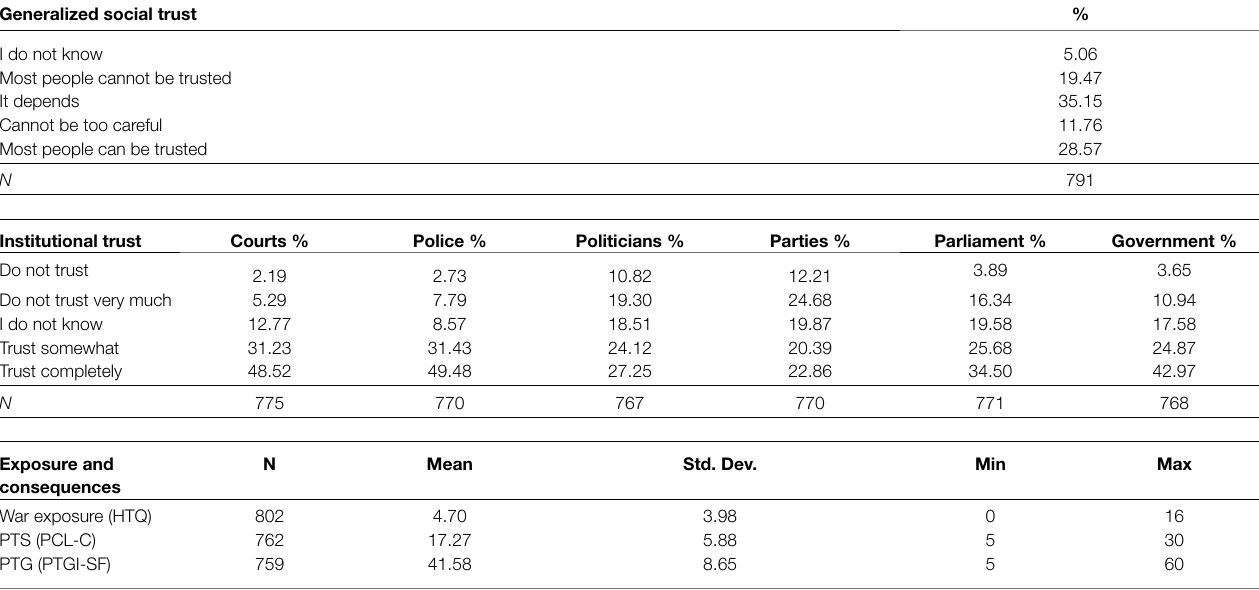
TABLE 2 | Distributions and summary statistics for key dependent and independent variables. Generalized social